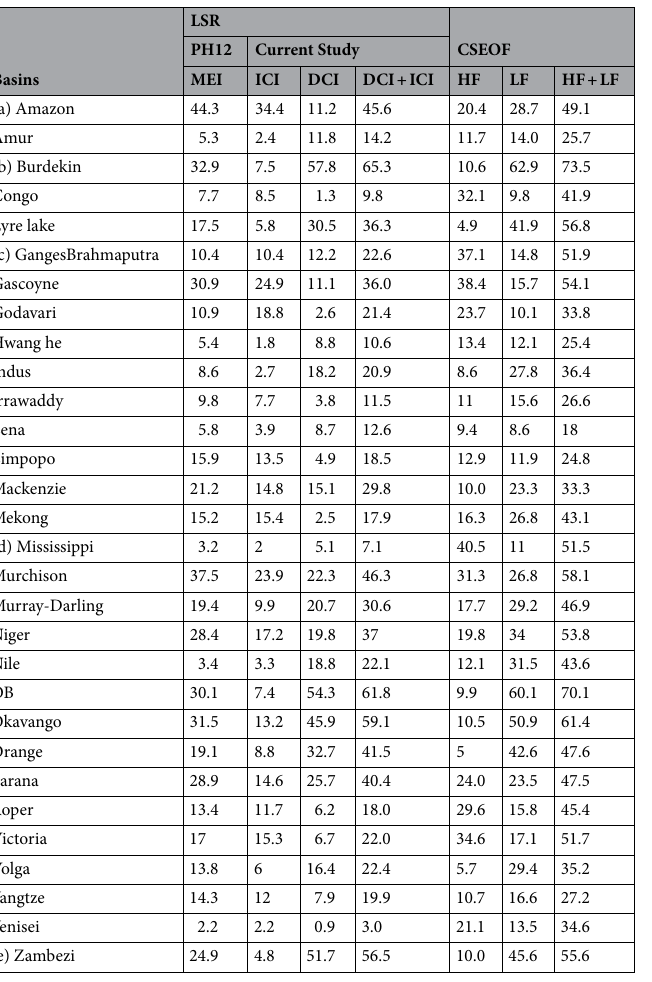
Table 1. Percentage of the variance of total TWS explained for river-basins around the